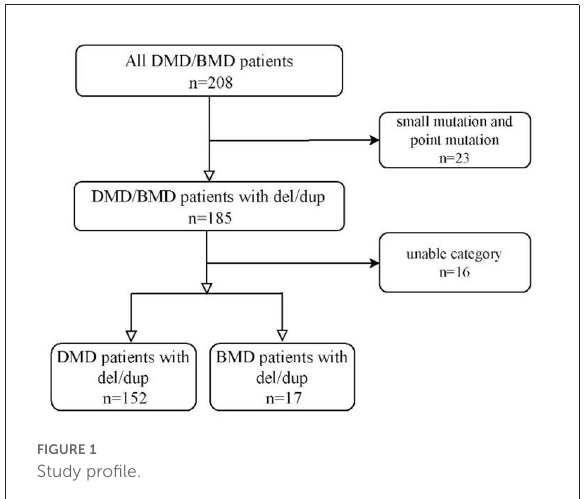
FIGURE1 Study profile.